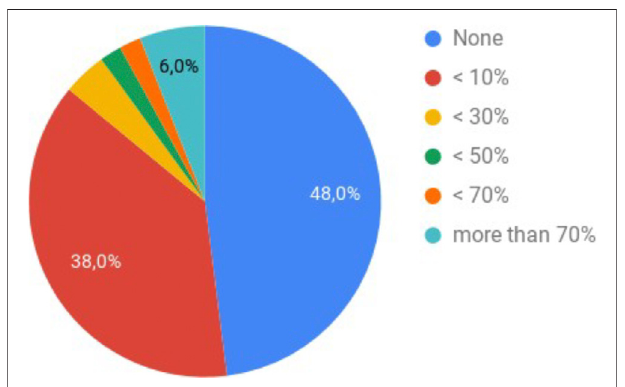
FIGURE 1 | Answers to the question: How many of the received e-mails are sent encrypted?.